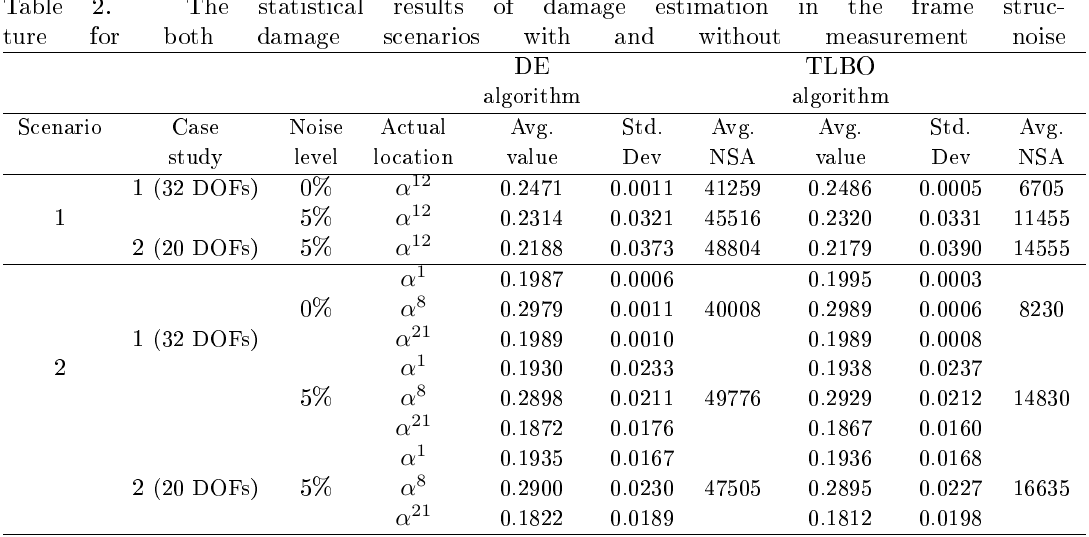
Table 2. The statistical results of damage estimation in the frame struc- ture for both damage scenarios with and without measurement noise DE TLBO algorithm algorithm